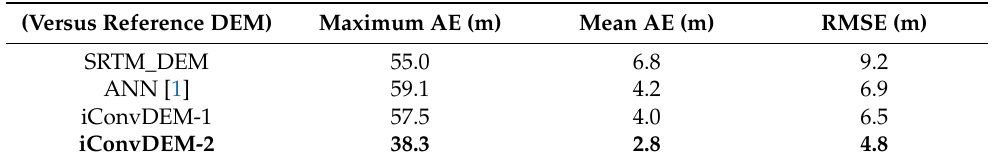
Table 2. Performance of all approaches versus reference DEM